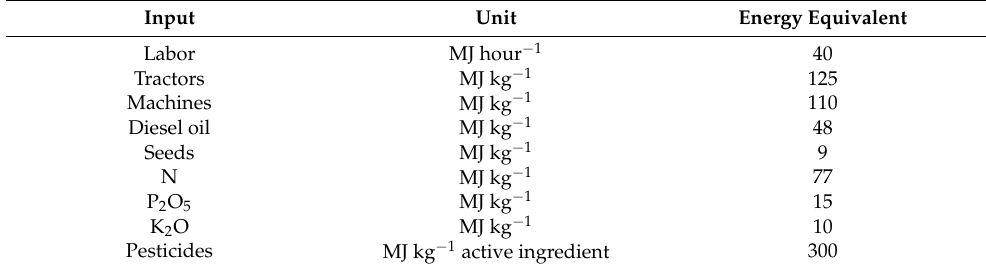
Table 2. Energy equivalence of inputs in the production technology